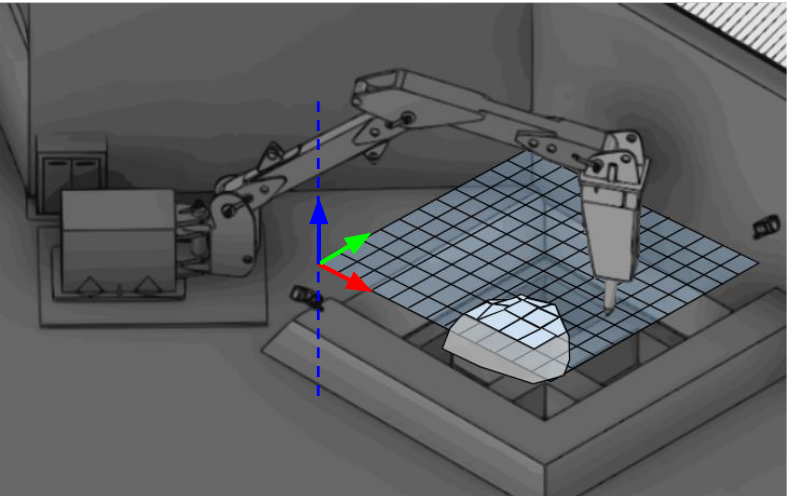
Figure 6. Grouping of points on the grizzly according to a parallel XY plane (the red, green and blue arrows represent the X , Y and Z axis, respectively). In light blue, a representation of the virtual grid utilized to perform the grouping of points. In white, the sub-regions found to be non-empty are displayed.